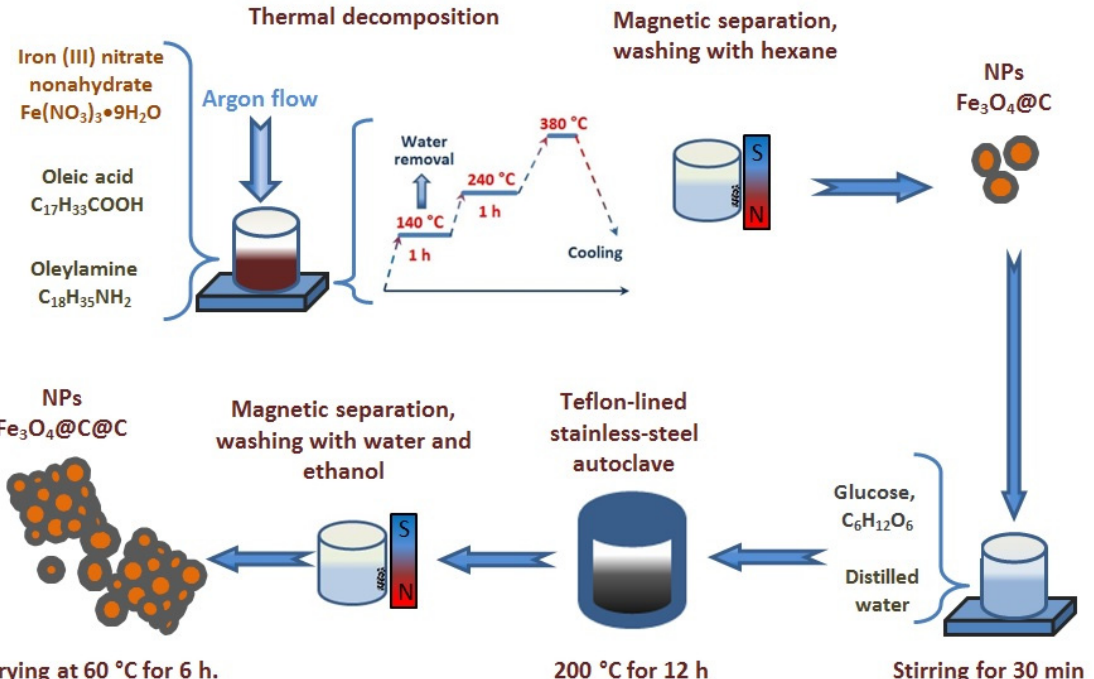
Figure 1. Schematic illustration of the NPs preparation steps. The equipment used is shown in a simplified simplified manner.